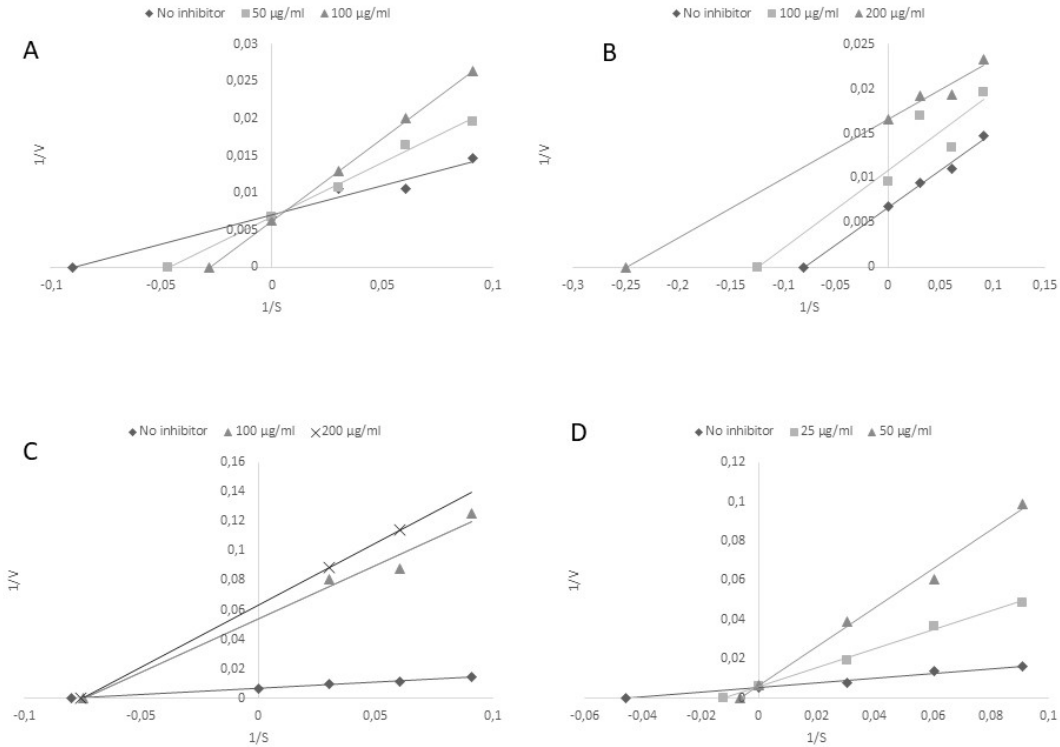
Figure 1. Lineweaver—Burk double reciprocal plots for the inhibition of TPO by rutin ( A ), quercetin ( B ), chlorogenic acid ( C ) and rosmarinic acid ( D ). Plots are expressed 1 / velocity versus 1 / guaiacol [ µ g / mL] without or with inhibitors in reaction solution. Table 4. Mode of inhibition, K i and V max values of chosen polyphenols on TPO activity, n = 9.